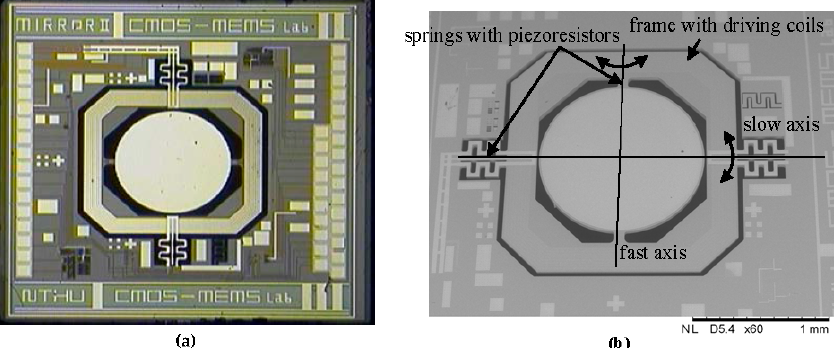
Figure 4. ( a ) Micrograph of the CMOS chip. ( b ) Scanning electron micrograph of the released scanning